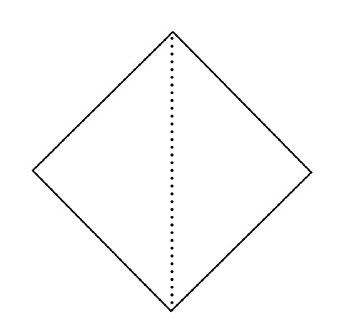
Figure 5. A Penrose diagram for a two-way traversable spacetime. The center vertical line describes a wormhole throat which connects the left and the right regions. From the above picture, a timelike traveller clearly can pass through the throat to go to the other region and also come back to the original